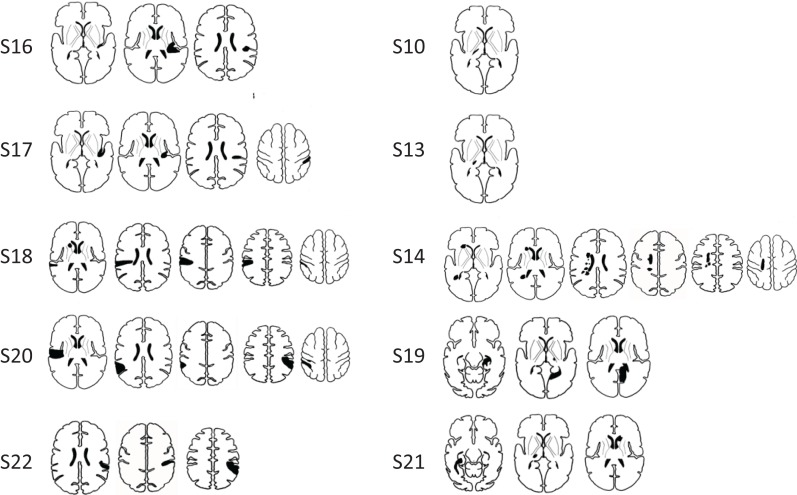
Infarct locations for individual stroke participants. Lesions were predominantly located in cortical somatosensory regions (SI and/or SII) (images in left column), and in somatosensory areas of the thalamus (images in right column). Infarct locations for each individual are plotted in stereotactic space. Images are displayed in neurological convention (subject’s left is displayed on image left).